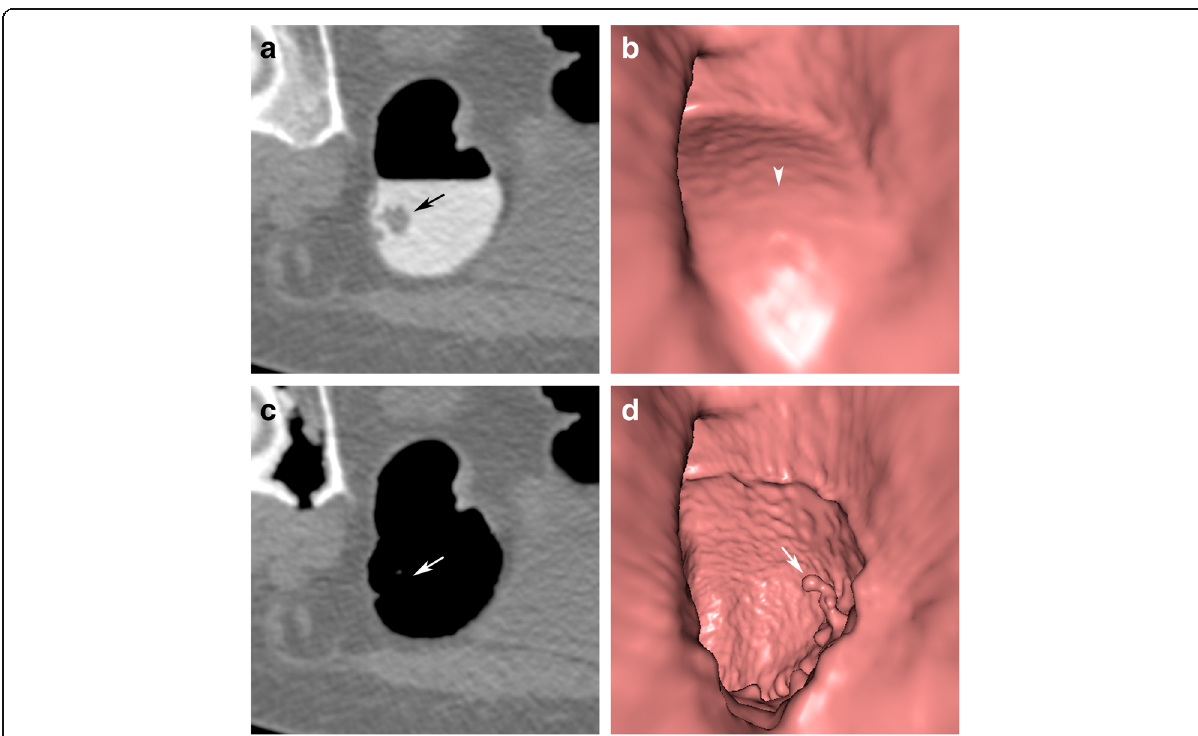
Fig. 11 Apparent removal of a 9-mm submerged pedunculated polyp, located at the sigmoid colon, due to EC. a A 9-mm pedunculated polyp, submerged under tagged residual fluid, is clearly visible in unsubtracted 2D image data in a wide window (arrow). b Before EC, a horizontal fluid layer (arrowhead) is seen on unsubtracted ebdoluminal 3D views, obscuring parts of the colonic wall. c After EC, the polyp apparently disappears on the 2D images (arrow). d On endoluminal 3D images, the polyp presents as an irregular, distorted filling defect